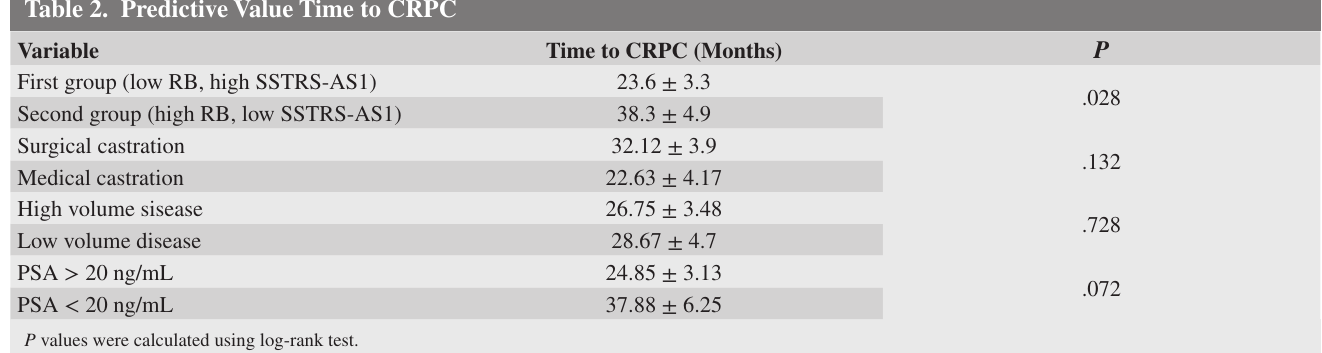
Table 2. Predictive Value Time to CRPC